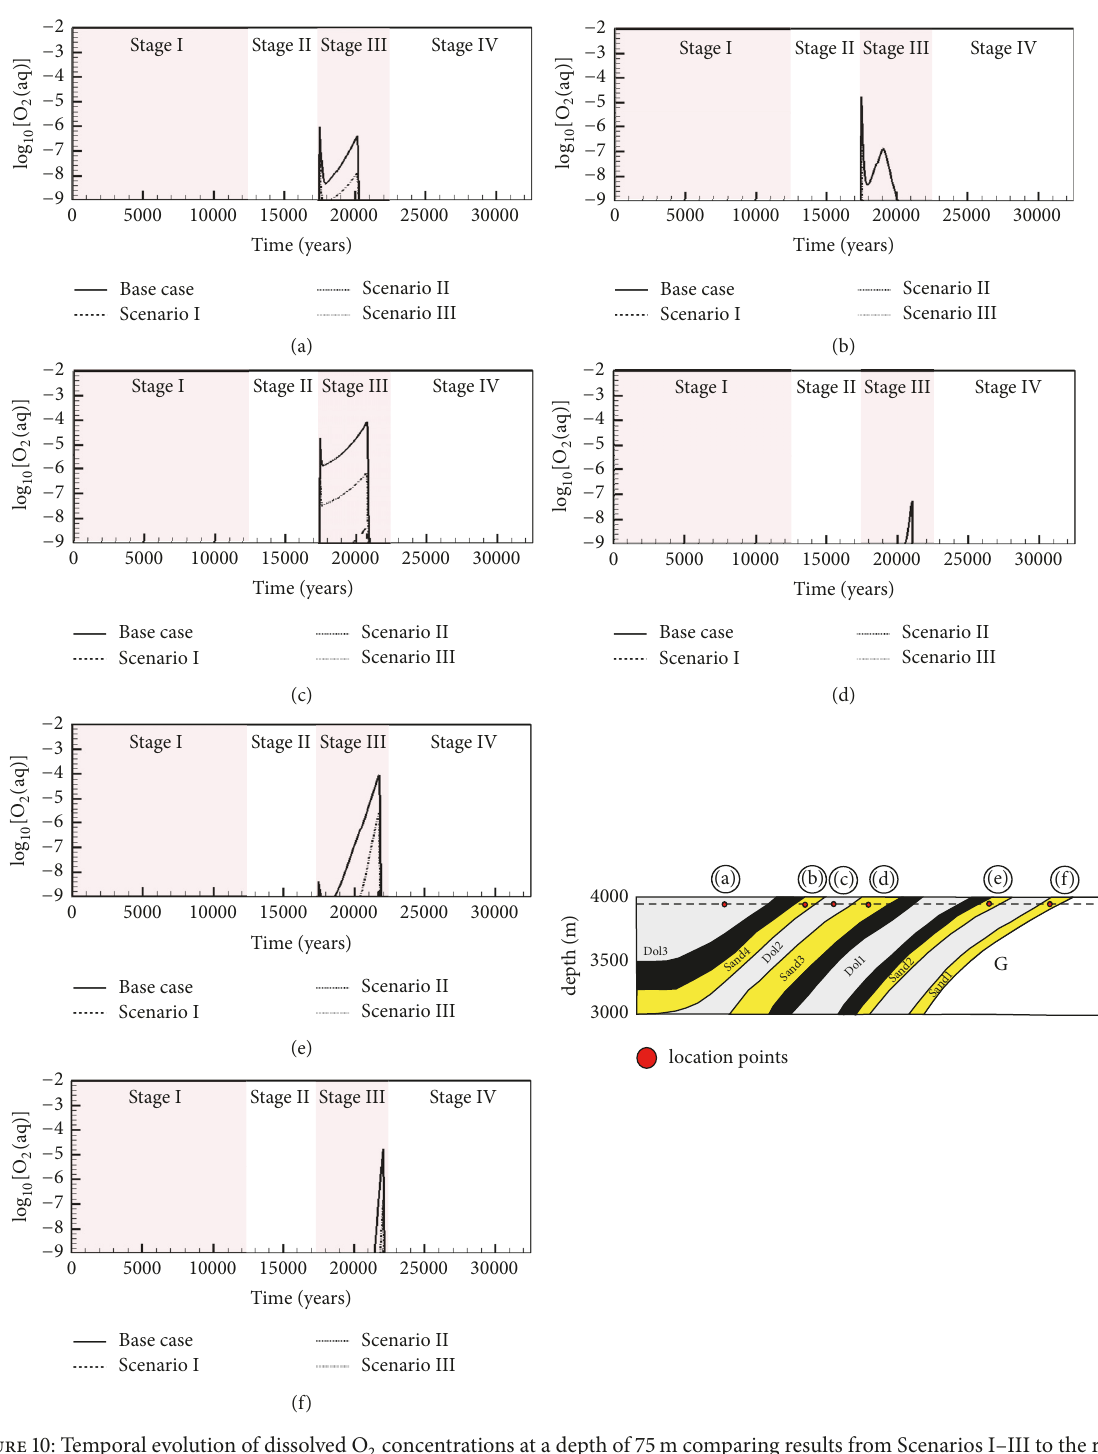
basin. The simulation results suggest that detailed